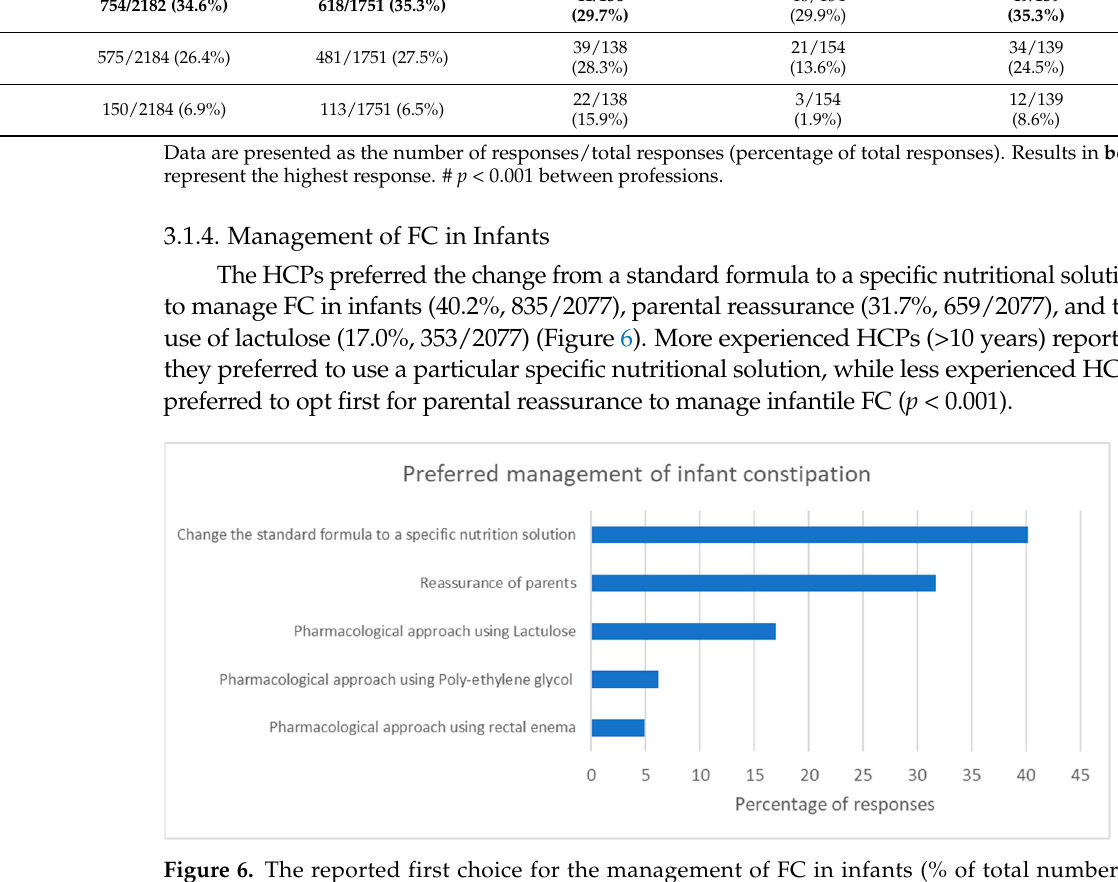
Table 1. The frequency of HCPs by profession reporting to have observed FC affecting (QoL) of infants and their parents in the last week.